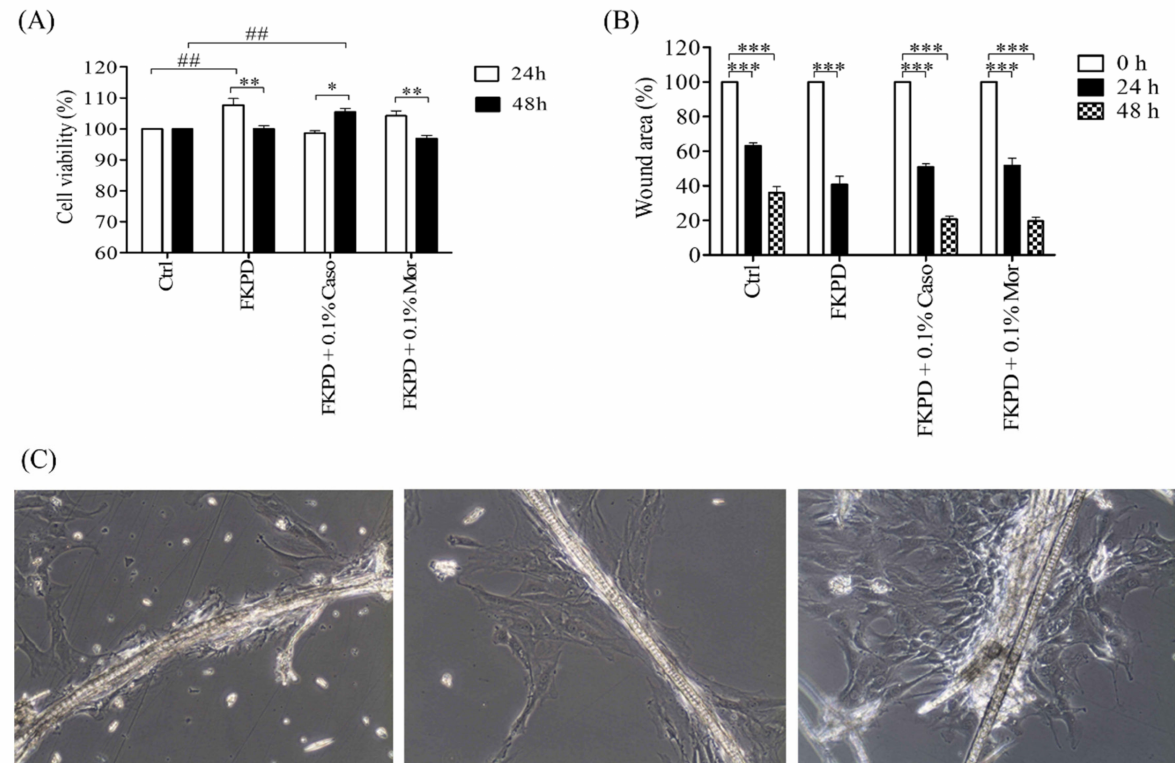
Figure 1. Effect of experimental dressings on cell viability ( A ) and migration ( B ) after 24 and 48 h. ( C ) NIH/3T3 cells growth on keratin biomaterials. (#-comparison control vs. treatment group) The data are statistically significant when p < 0.05, were: * p -value < 0.05, ** p -value < 0.01, ## p -value < 0.01, *** p -value < 0.001), two-way analysis of variance, followed by Bonferroni post hoc tests, mean ± standard error of the